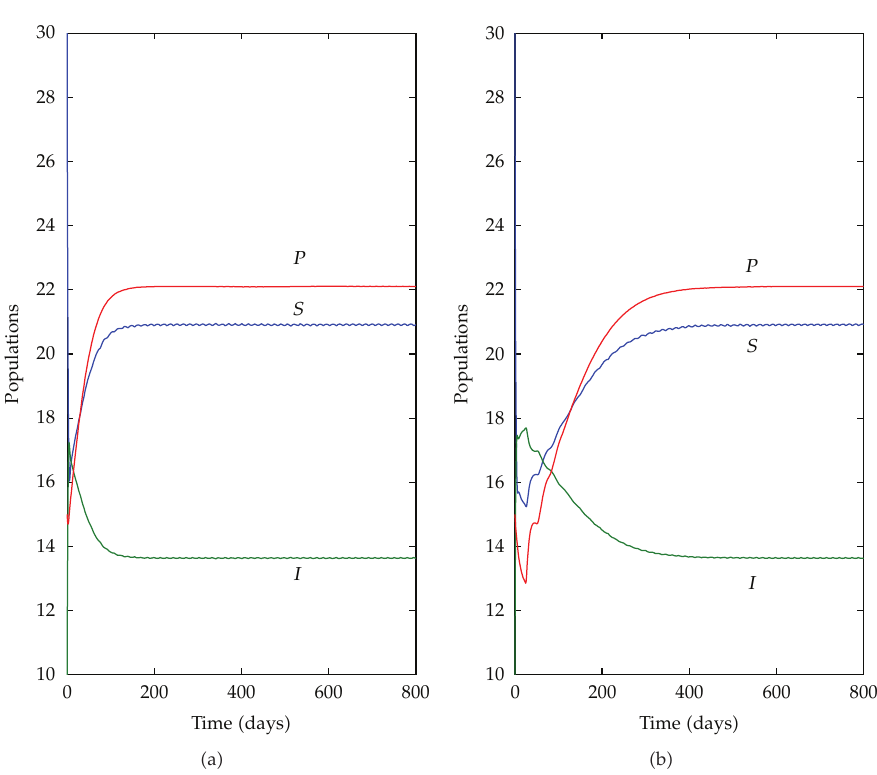
Figure 2: Time series solutions of the prey and predator populations of the system (cid:7) 1.2 (cid:8) : (cid:7) a (cid:8) τ (cid:5) 1, (cid:7) b (cid:8) τ (cid:5) 25. Parameter values are given in the text. This figure shows that the coexisting equilibrium E ∗ is absolutely stable for all